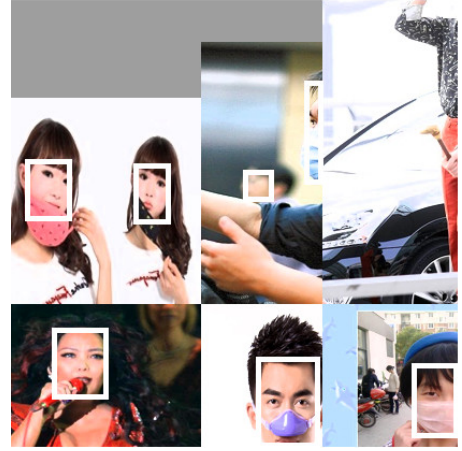
Figure 7. Improved mosaic data enhancement.